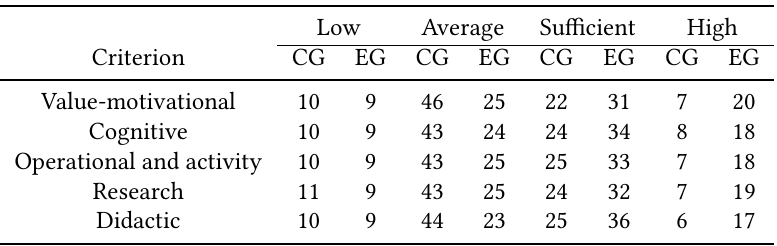
Table 3 Levels of formation of digital competence of CS bachelors in the use of CBLE in control (CG) and experimental (EG) groups (after the experiment).